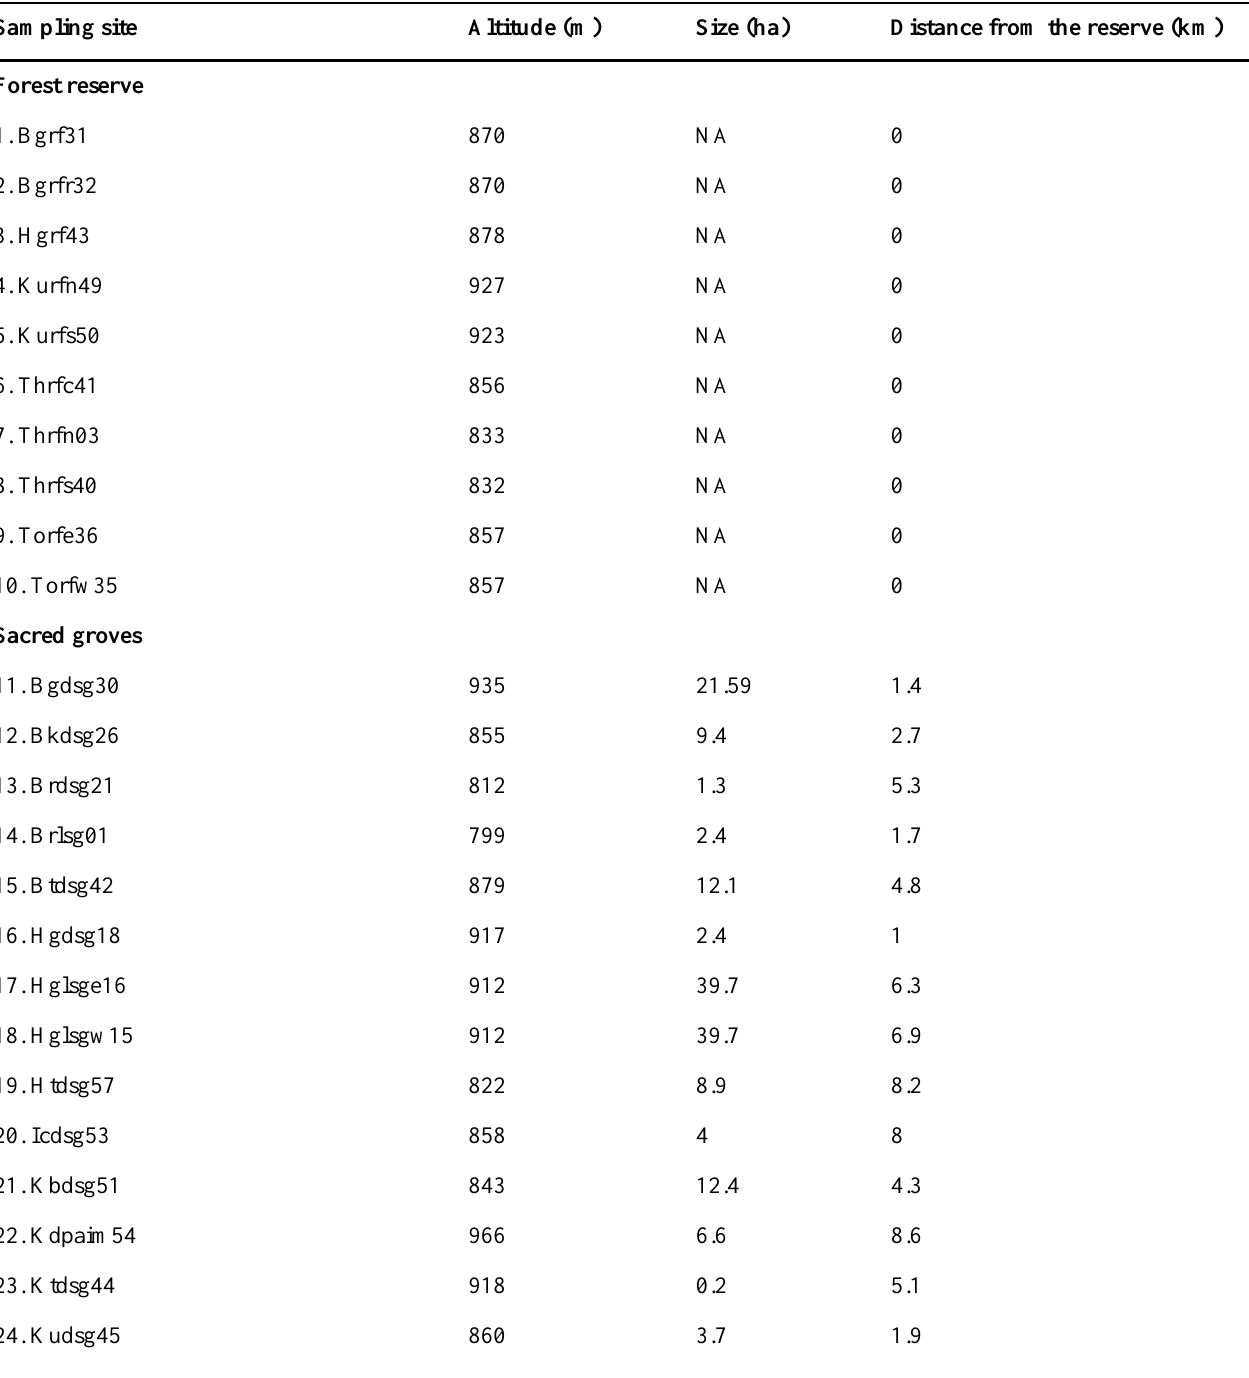
Table 1. List of sampling sites in Kodagu, Western Ghats of India; the sites are identified by alphanumeric codes consisting of abbreviated village names and sampling reference numbers Sampling site Forest